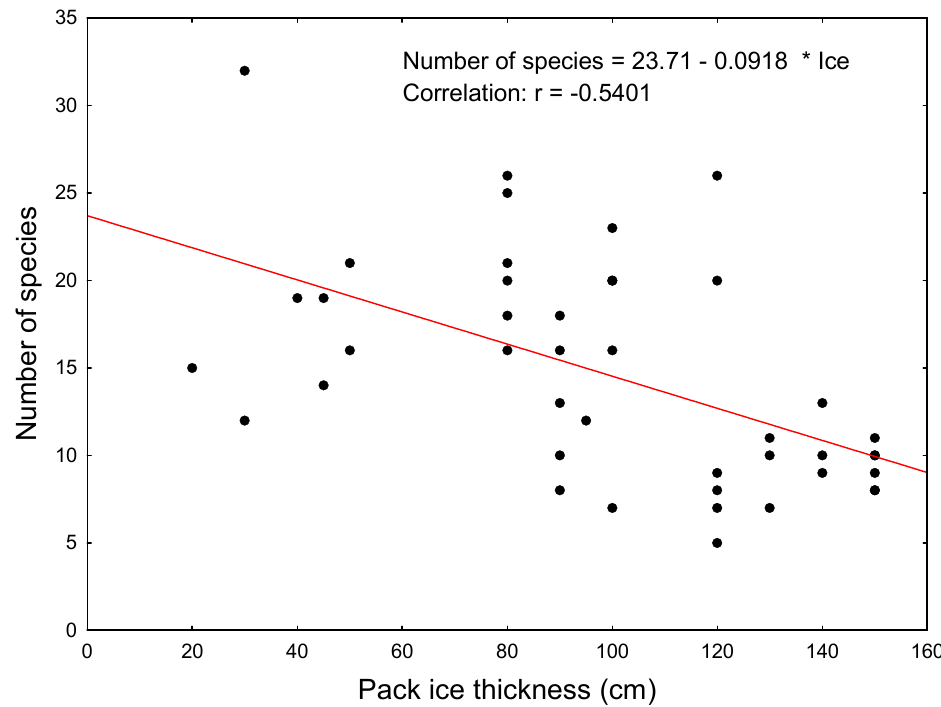
Figure 5. Regressions of the pack ice thickness and the total number of ice algal species in the Barents Sea.